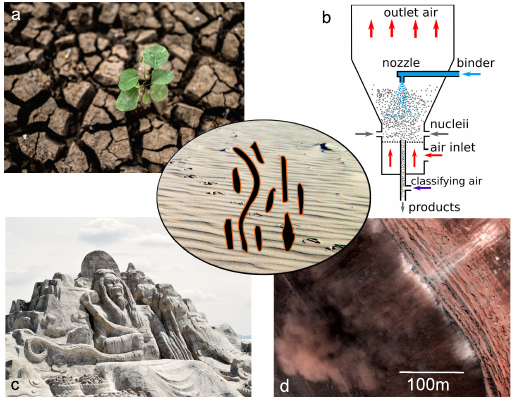
Figure 1: A combination of ‘microscopic’ sand grains and ‘macroscopic’ sand ripples forms the character ‘sand’ in Chinese (overlaid in the middle) as ap- peared in bronze inscriptions over three millennia ago. The ubiquity of particulate materials determines their widespread applications in diverse disciplines, such as (a) ecology (image courtesy of Freepik), (b) granula- tion process in chemical engineering, (c) sculpturing and construction (sculpture at the Chaka salt lake), and (d) geo-science and space exploration (avalanches on Mars)